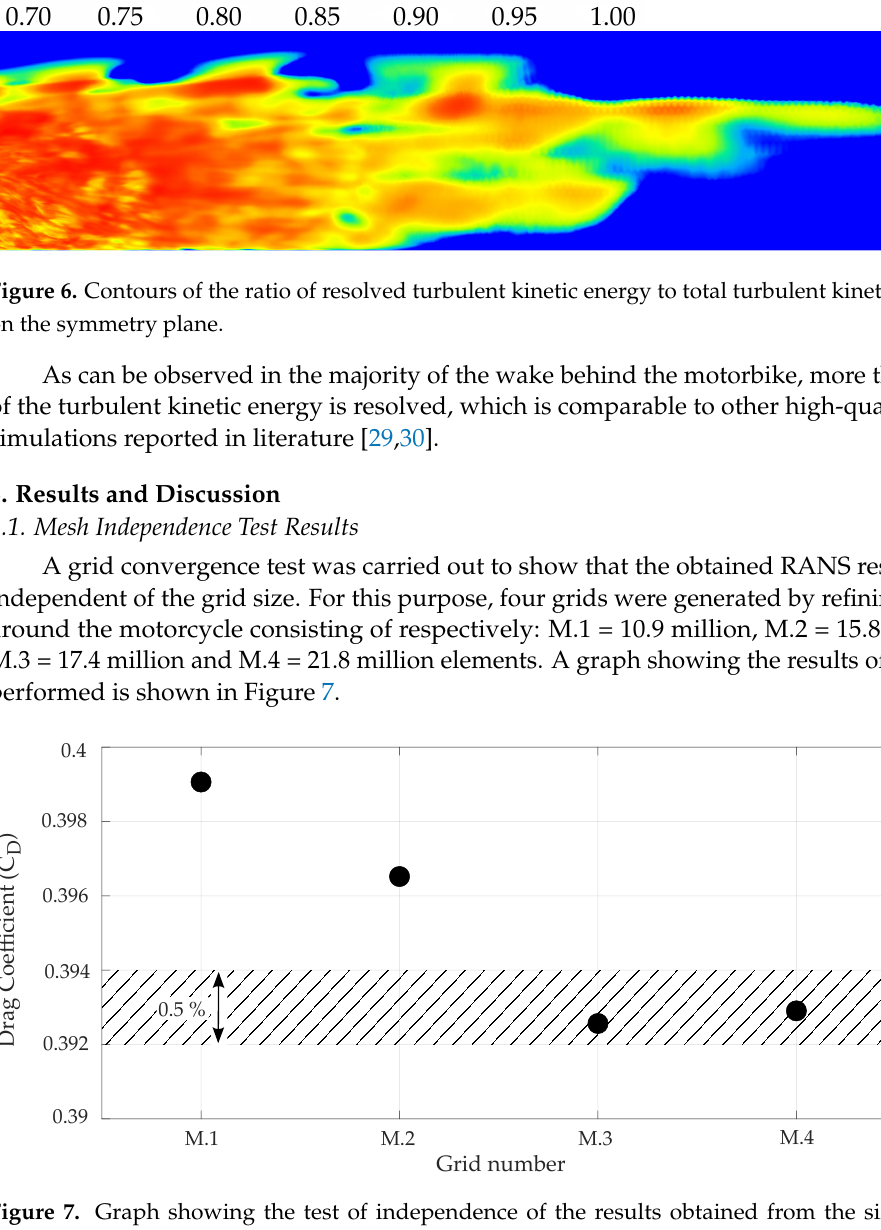
Figure 7. Graph showing the test of independence of the results obtained from the size of the calculation